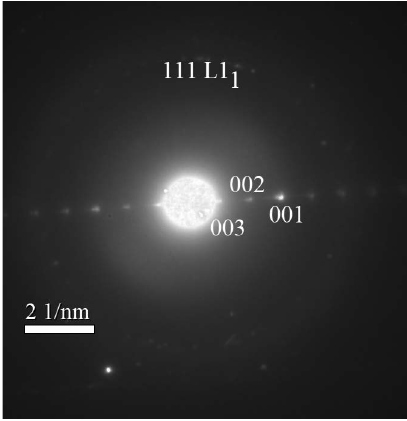
Figure 6. A SAED pattern showing, besides the (002) spot, the superlattice peaks (001) and (003) characteristic to the highly ordered fct L1 0